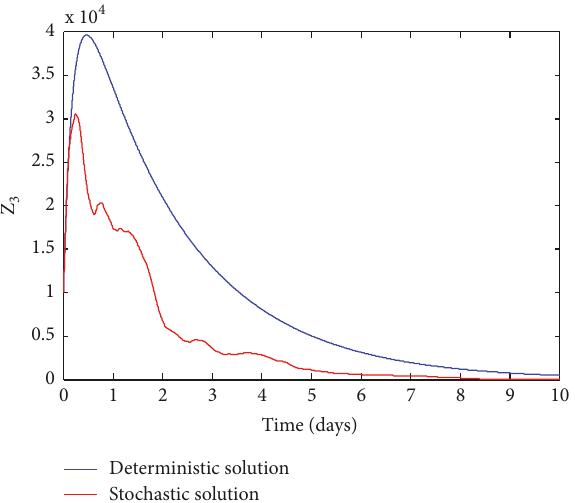
Figure 3: The approximate stationary solutions of 𝑍 3 obtained for equations (1) and (5) with 𝜎 1 = 0.5 and 𝜎 2 = 0.5